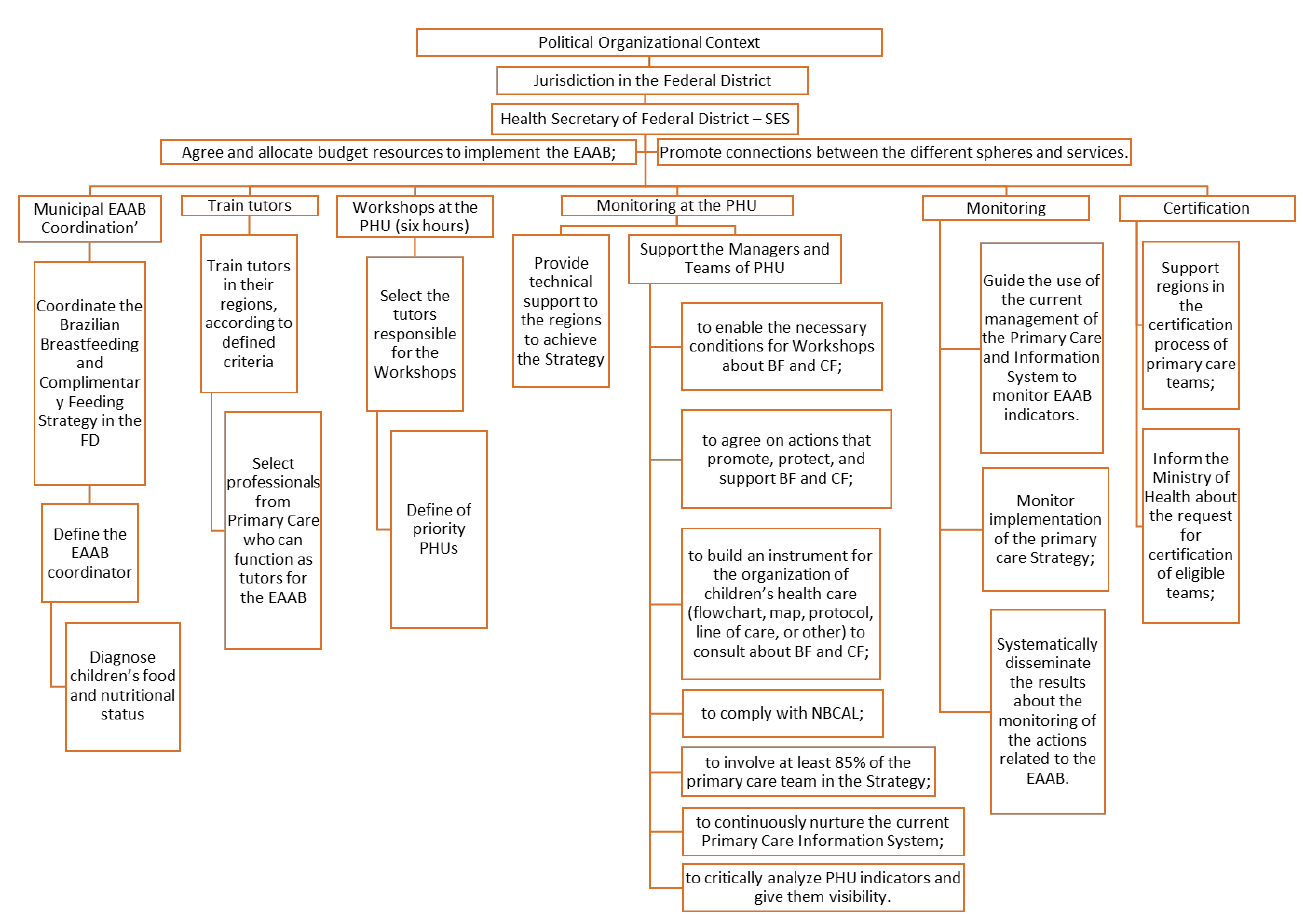
Figure 2. Logical model for the implementation of the EAAB in the Federal District .